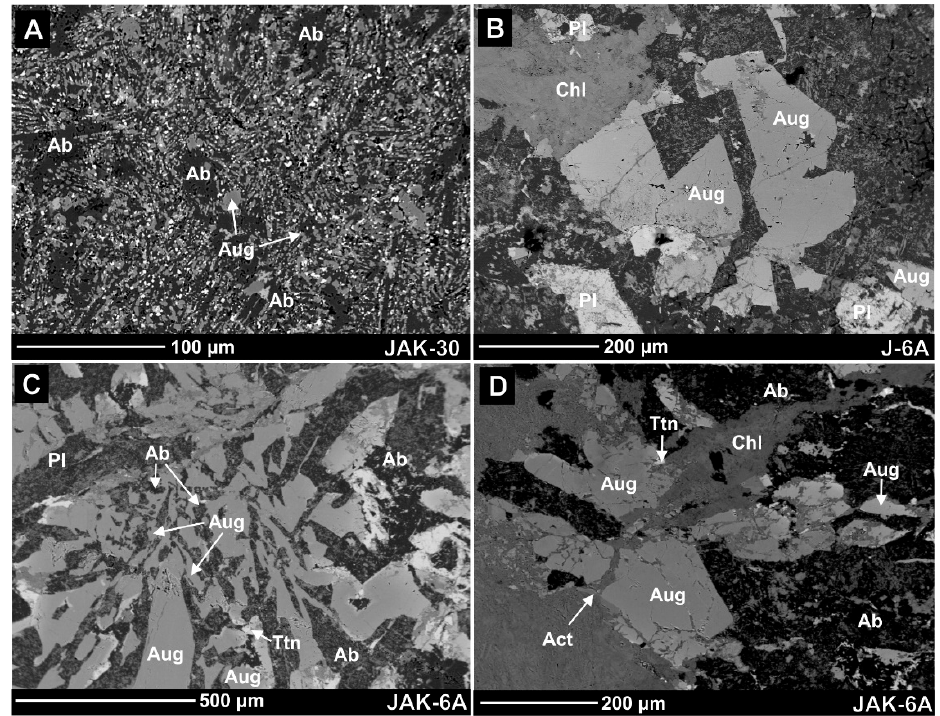
Figure 12. BSE images of the relic magmatic textures from the Jaklovce Unit metabasalts and metadolerites: ( A ) fine-grained metabasalt (s. JAK-30) with a well preserved ophitic texture of Aug and albitised Pl; ( B ) metadolerite (s. J-6A) with partly chloritised porphyric Aug and albitised Pl in Aug and Pl / Ab fine grained matrix; ( C ) dolerite texture (s. JAK-6A) with intergrown Aug and Pl; and ( D ) metadolerite (s. JAK-6A) crosscut by a metamorphic Chl–Act